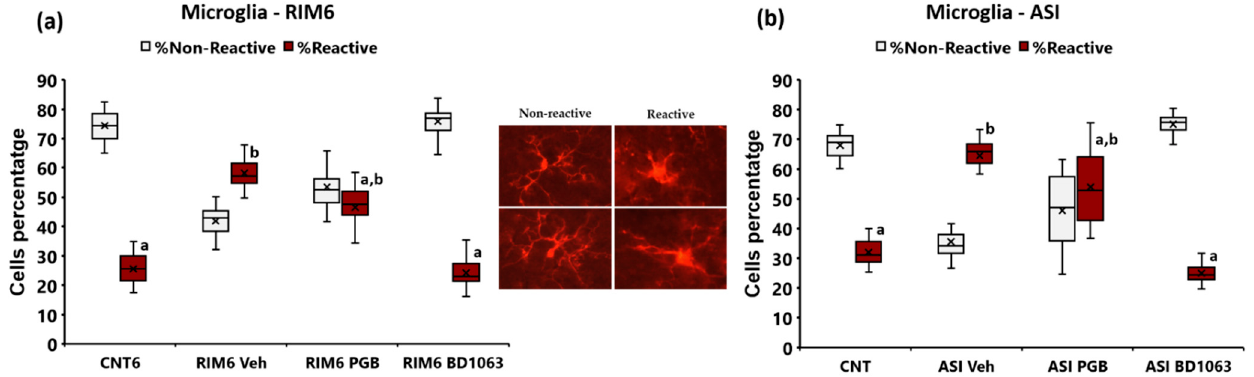
Figure 6. Spinal cord microgliosis in mice subjected to ( a ) reserpine-induced myalgia and ( b ) intra- muscular acid saline solution injection, and treated with saline solution, BD1063, or pregabalin. In the middle, representative nonreactive and reactive microglial cells. Note that reactive cells have an amoeboid form, a larger nucleus, and shorter branching processes than nonreactive cells. Images were captured at regions subjected to astrogliosis analysis. Data are expressed as the median ± IQR, and the mean is shown as x. a,b: Groups not sharing a letter showed significant differences with respect to control group, p < 0.05.